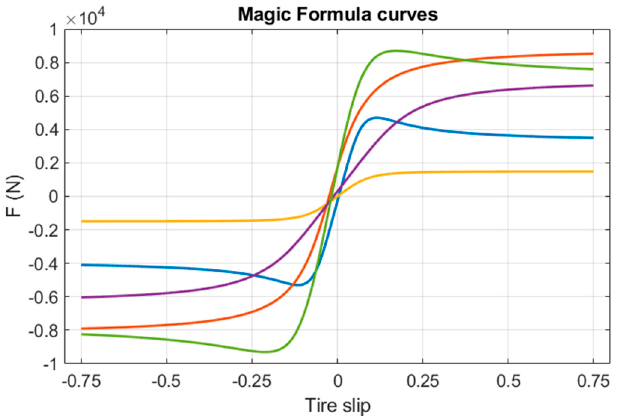
Figure 3. Some MF curves generated by random parameters.